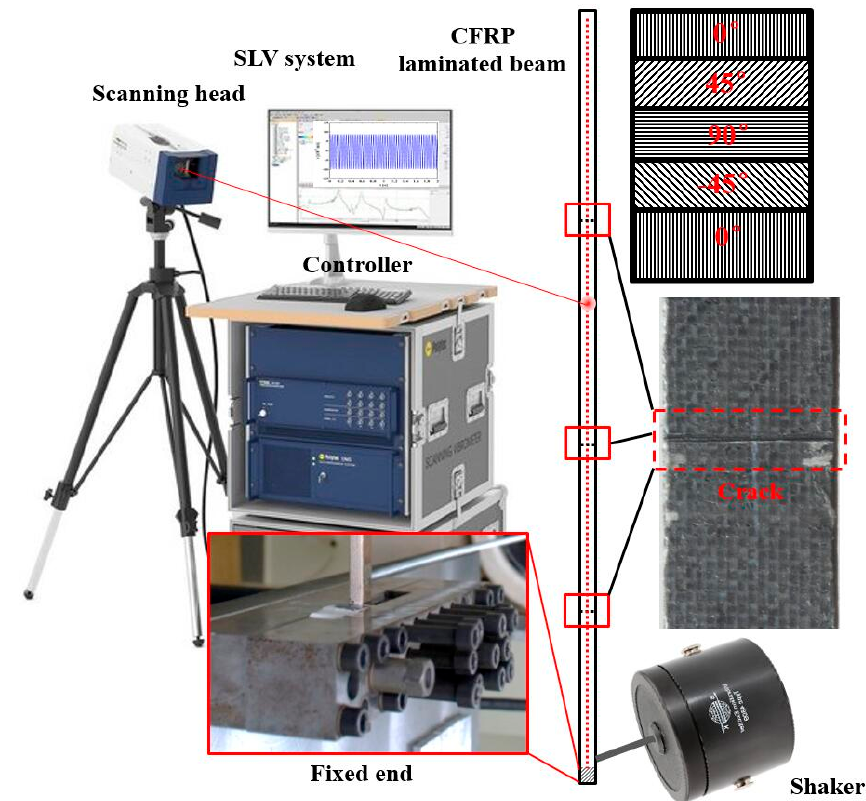
Figure 11. SLV system.